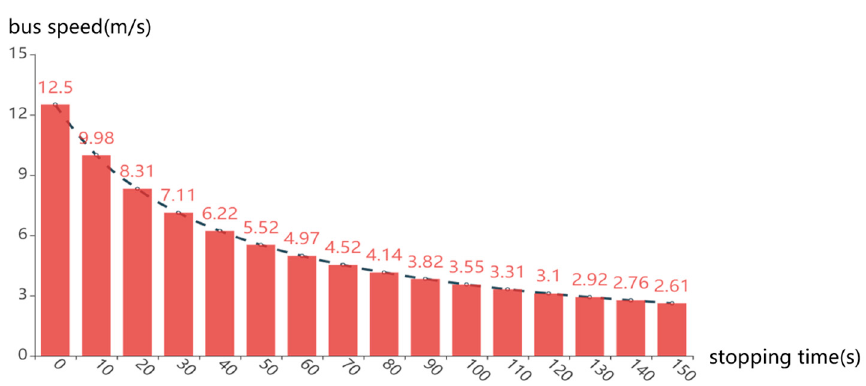
Figure 9. Speeds corresponding to different stopping time.